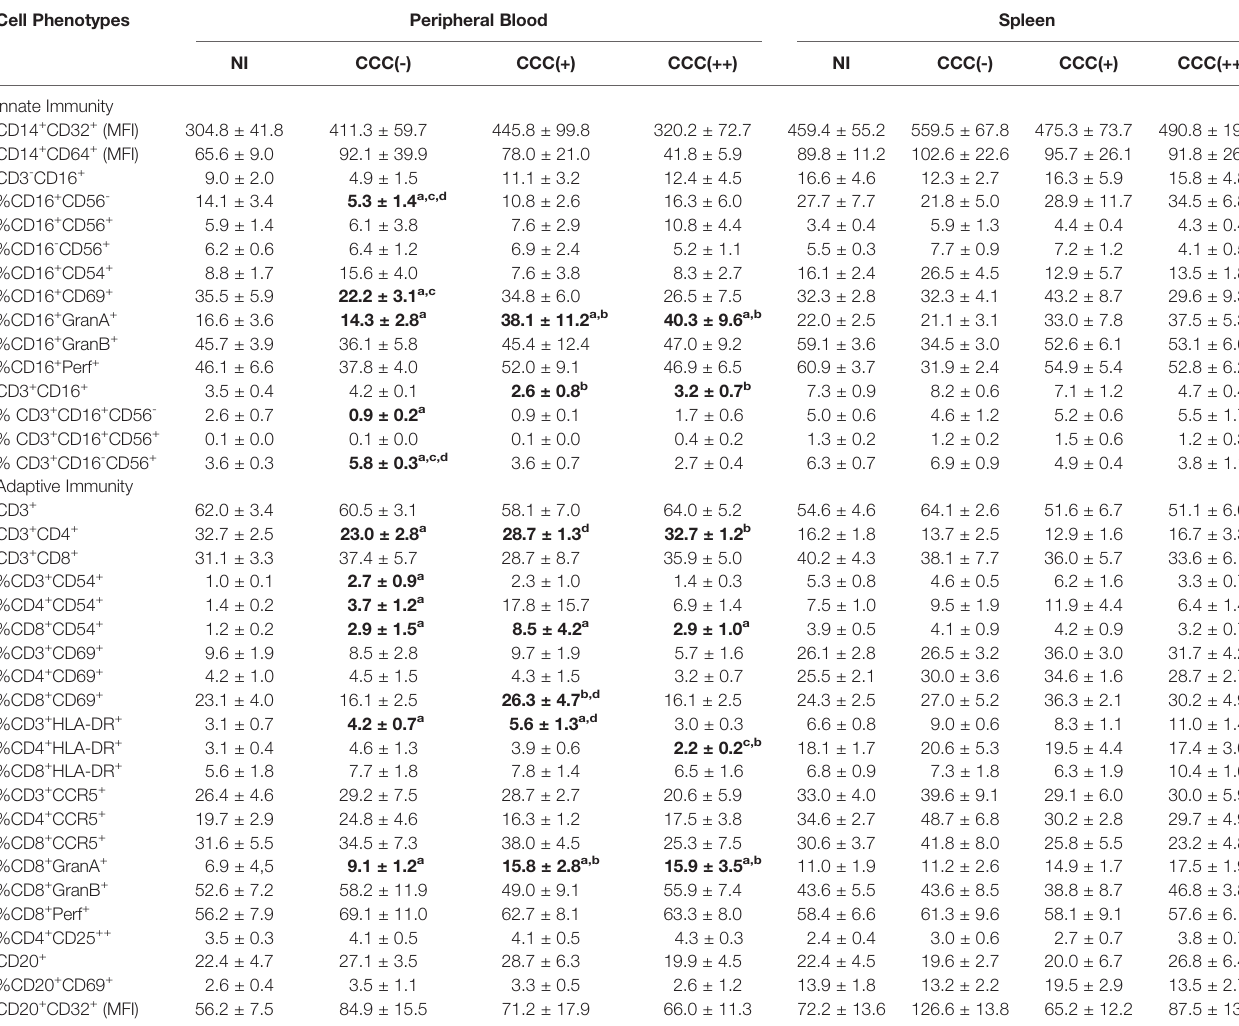
TABLE 1 | Phenotypic features of peripheral blood and spleen leukocytes from T. cruzi-infected cynomolgus macaques. Cell Phenotypes Peripheral Blood